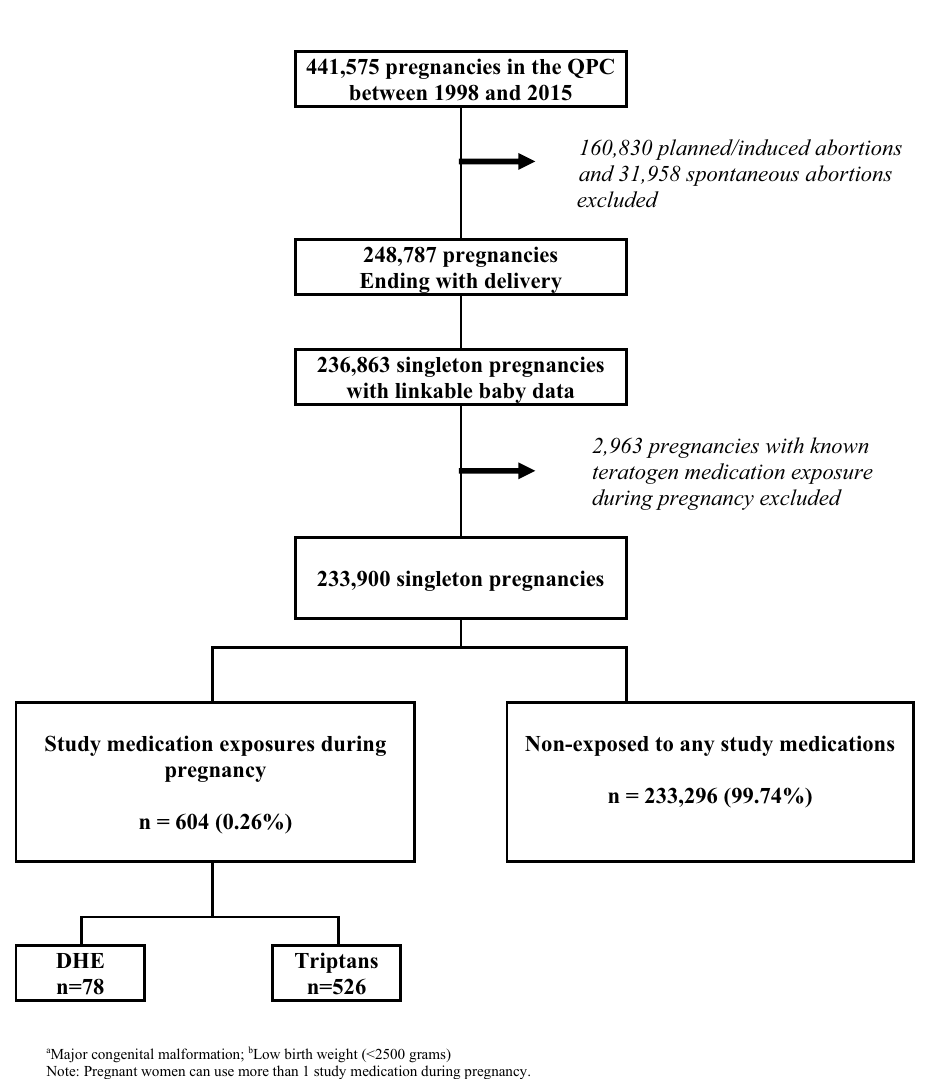
Figure 1. Selection of the study population for analyses on MCM a , prematurity, and LBW b